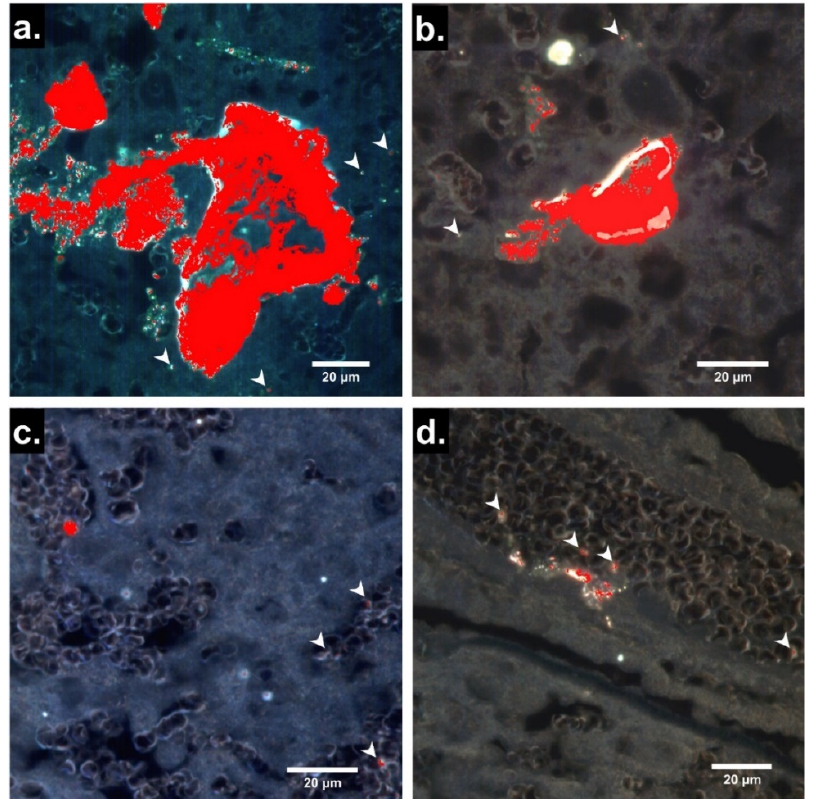
Figure 3. Localization by EDHM of 25 nm carboxylate ‐ modified polystyrene MNPs (PS25C) in rat placenta 24 h after oral gavage. ( a – d ) Enhanced darkfield hyperspectral microscopy (EDHM) images of 4 μ m sections of placentas from pregnant rats gavaged with 10 mL/kg of 250 μ g/mL PS25C in water on GD19 and sacrificed on GD20. Pixels that carry the hyperspectral information of PS25C are overlaid in red. Arrowheads indicate smaller discrete PS25C signals.